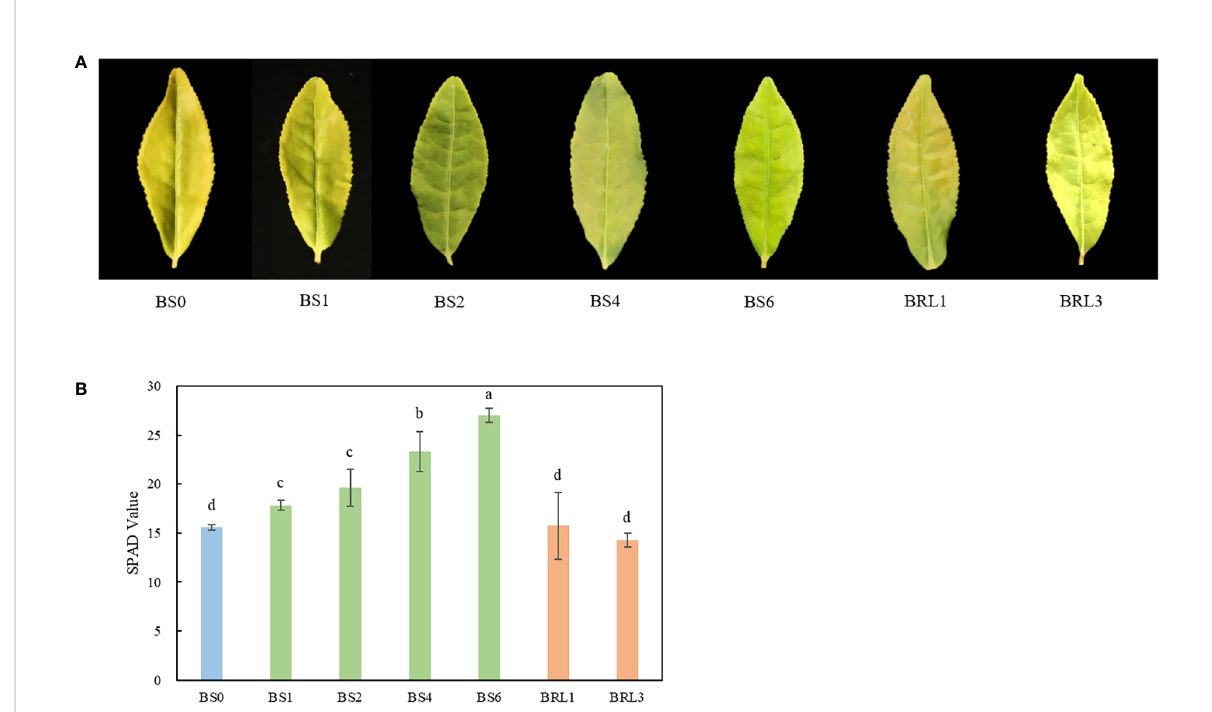
FIGURE 1 Leaf color phenotype and the SPAD value of BJG after shading and recovery light treatments. (A) Phenotypic expression and (B) the SPAD value of BJG under natural light (BS0), shading for 1 day (BS1), shading for 2 days (BS2), shading for 4 days (BS4), shading for 3 days then light recovery for 1day (BRL1), and shading for 3 days then light recovery for 3 days (BRL3). Data and error bars are the mean ± SD (n = 5). Different lowercase letters indicate a signi fi cant difference between the means at P